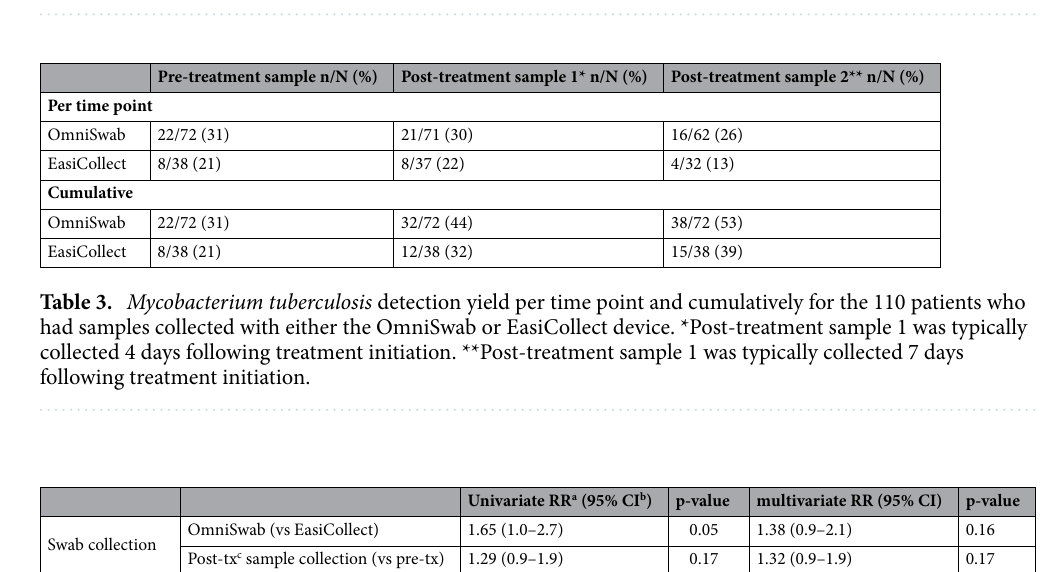
Table 2. Detection of Mycobacterium tuberculosis per sample (upper panel) and per patient (lower panel). a CI confidence interval. b SM smear-microscopy. c tx treatment.